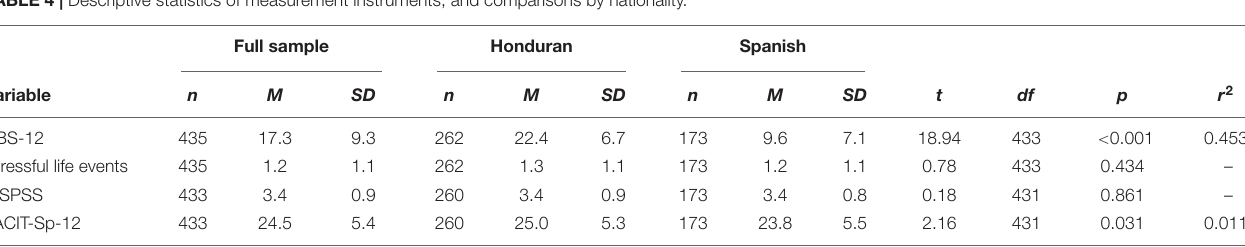
TABLE 4 | Descriptive statistics of measurement instruments, and comparisons by nationality. Full sample Honduran